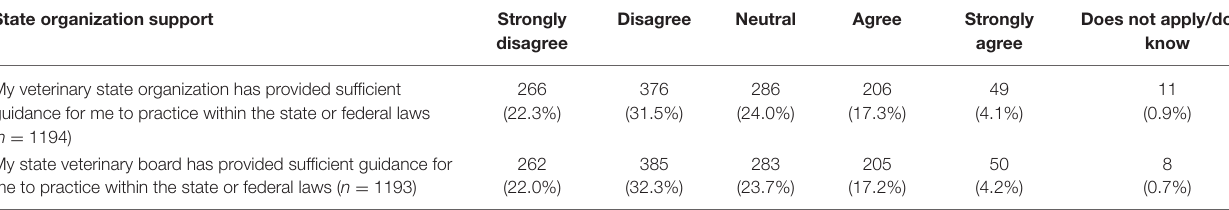
TABLE 7 | Perception of state organizations’ provision of sufficient guidance regarding the use of CBD/marijuana in animals to practice within the state or federal laws.